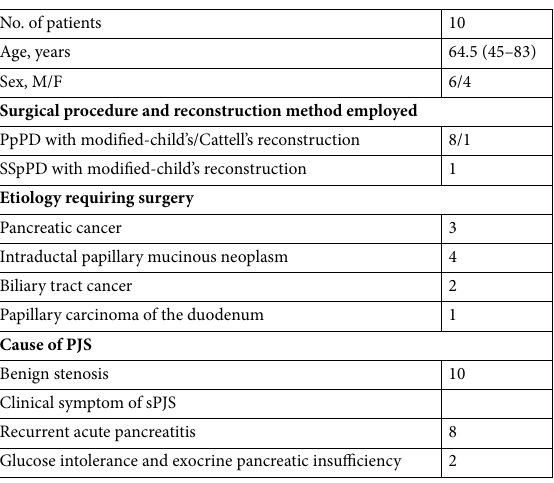
Table 1. Characteristics of patients. M male, F female, PpPD pylous-preserving pancreaticoduodenectomy, SSpPD subtotal stomach-preserving pancreaticoduodenectomy, PJS pancreaticojejunal anastomotic stenosis, sPJS symptomatic pancreaticojejunal anastomotic